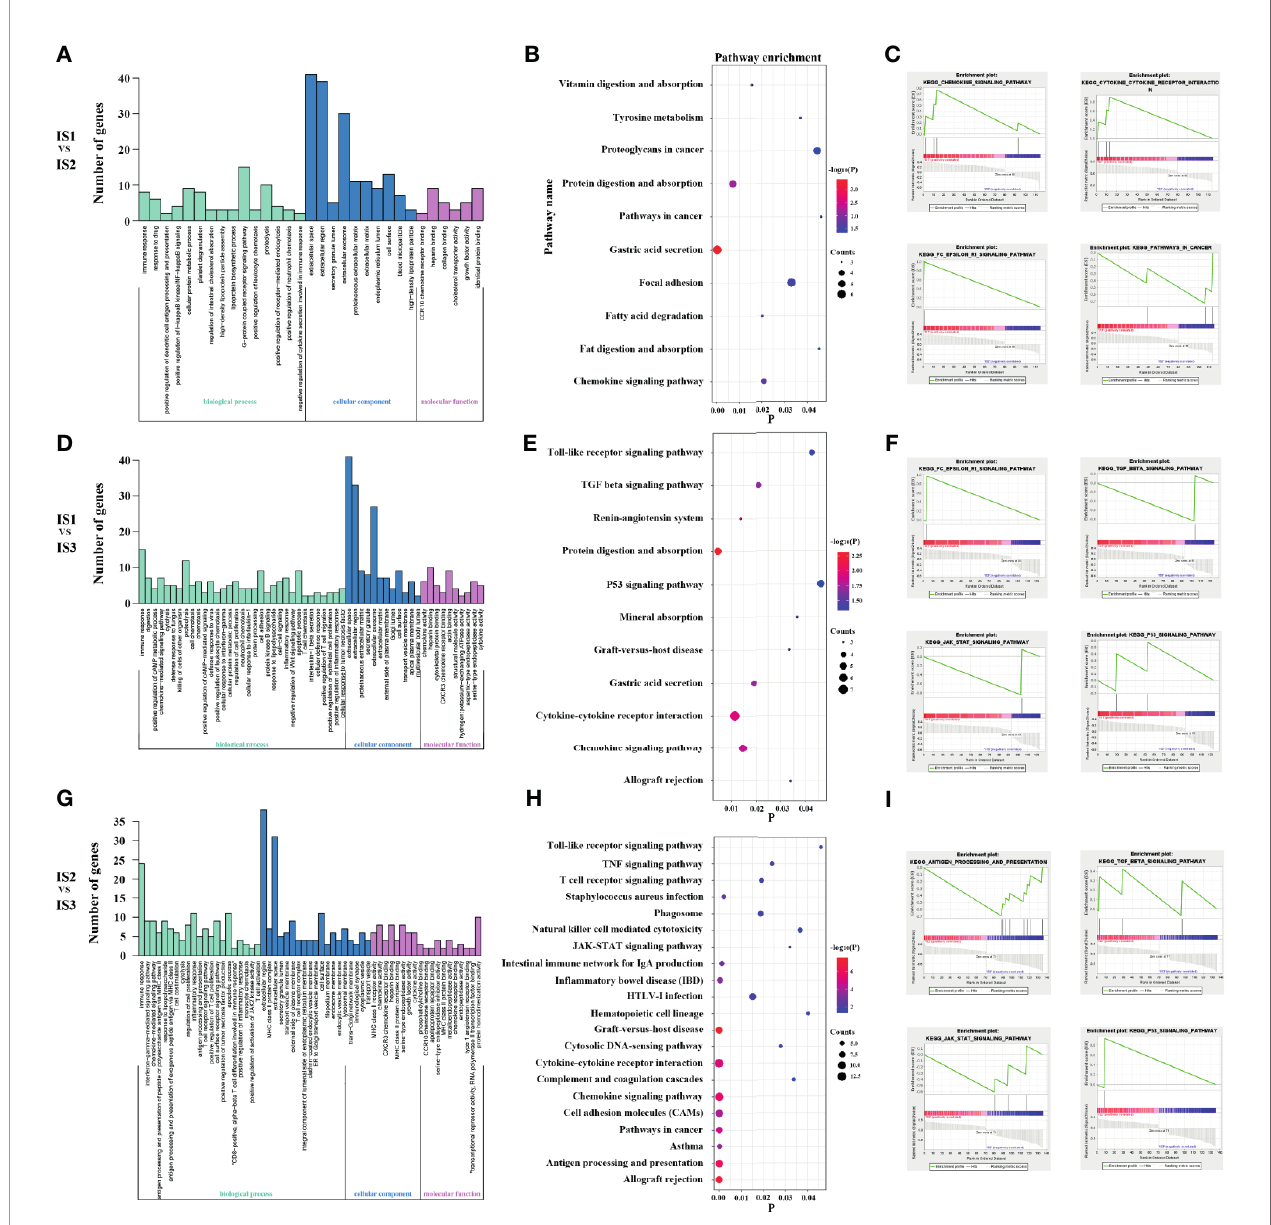
FIGURE 5 | Lots of cytokine secretion and immune regulation pathways were found in the GO, KEGG and GSEA analysis for IS1 vs IS2 (A – C) . Lots of classical tumor and immune-related pathways were found in the GO, KEGG and GSEA analysis for IS1 vs IS3 (D – F) . Lots of classical tumor and immune-related pathways were found in the GO, KEGG, and GSEA analyses for IS2 vs IS3 (G – I) . These suggest more active immune respond and antitumor reaction in